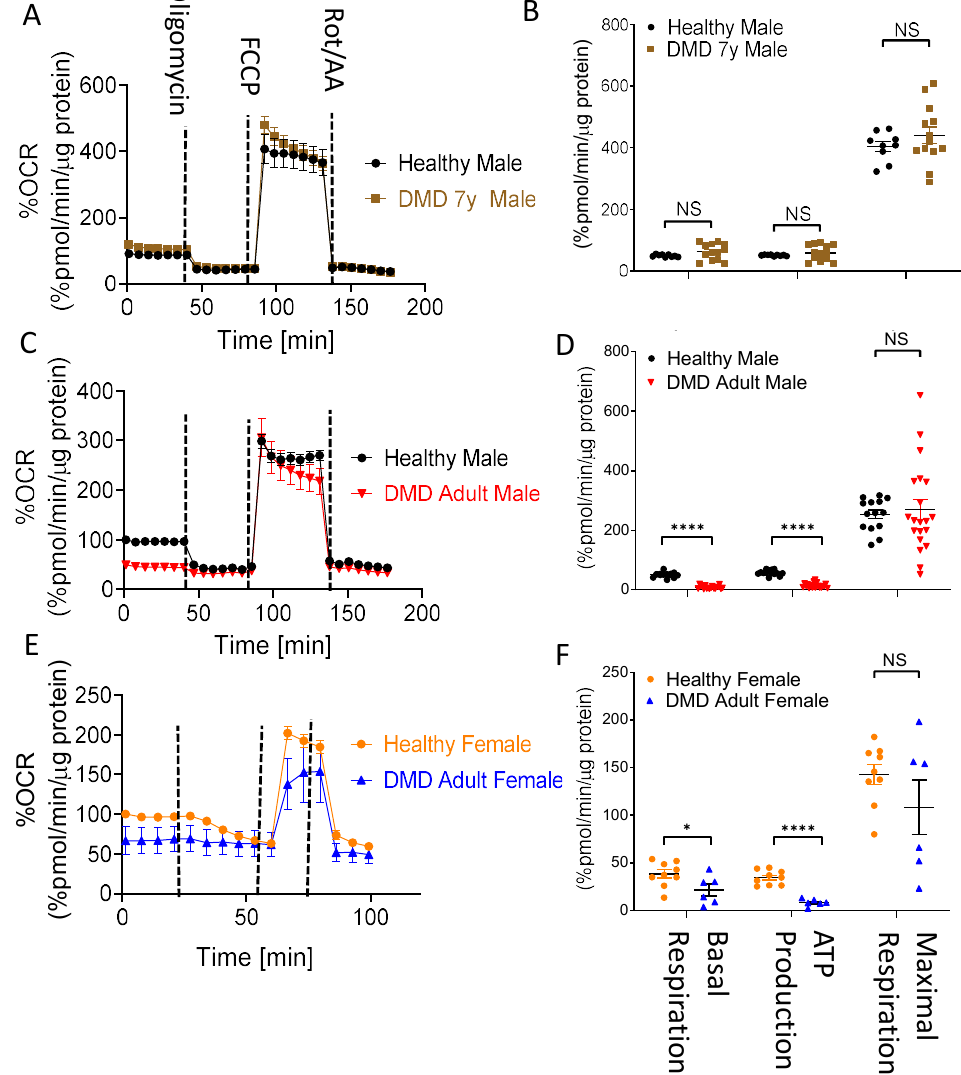
Figure 4. Respiration profiles for DMD vs. healthy control iPSC-CMs. ( A , C , E ) Oxygen consumption rate (OCR) in DMD 7-year-old (7y), DMD adult male and DMD adult female compared to healthy CMs. ( B , D , F ) Basal respiration, ATP production and maximal respiration rates in the different experimental groups. OCR was recorded during sequential additions of respiration modulators: (1) oligomycin, (2) FCCP and (3) antimycin A and rotenone. Basal respiration, ATP production and maximal respiration rates calculated according to Supplementary S5 and based on the relevant OCR plots for each cell line. OCR values are normalized to µ g protein measured using the modified Lowry protein assay and are compared to the basal OCR of a health (defined as 100%). Healthy, n = 9–14; DMD 7y, n = 13; DMD adult male, n = 20; DMD adult female, n = 6. Kruskal–Wallis test (for non-normal distribution); NS = non-significant, * p < 0.05, **** p < 0.0001.